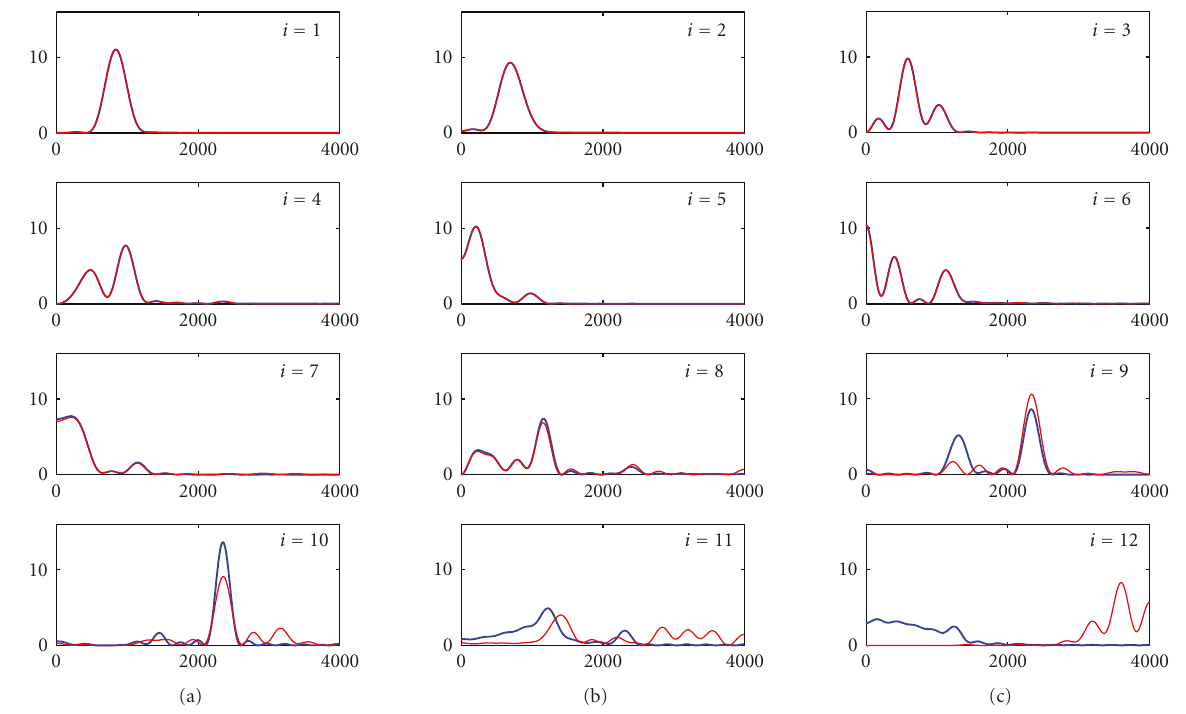
Figure 13: Frequency responses (Magnitude (dB) versus Frequency (Hz)) for the SVD/ULV canonical filters defined by the columns of W k and W L , k in (89). Thick blue lines are SVD canonical filters; thin red lines are ULV canonical